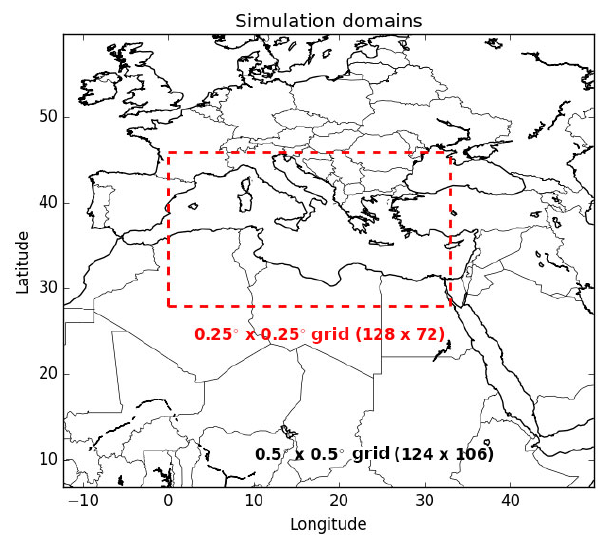
Figure A1. Simulation domains including one large domain (with a 0 . 5 ◦ × 0 . 5 ◦ horizontal resolution) and a smaller domain (at a 0 . 25 ◦ × 0 . 25 ◦ horizontal resolution) delimited by the dotted red box.